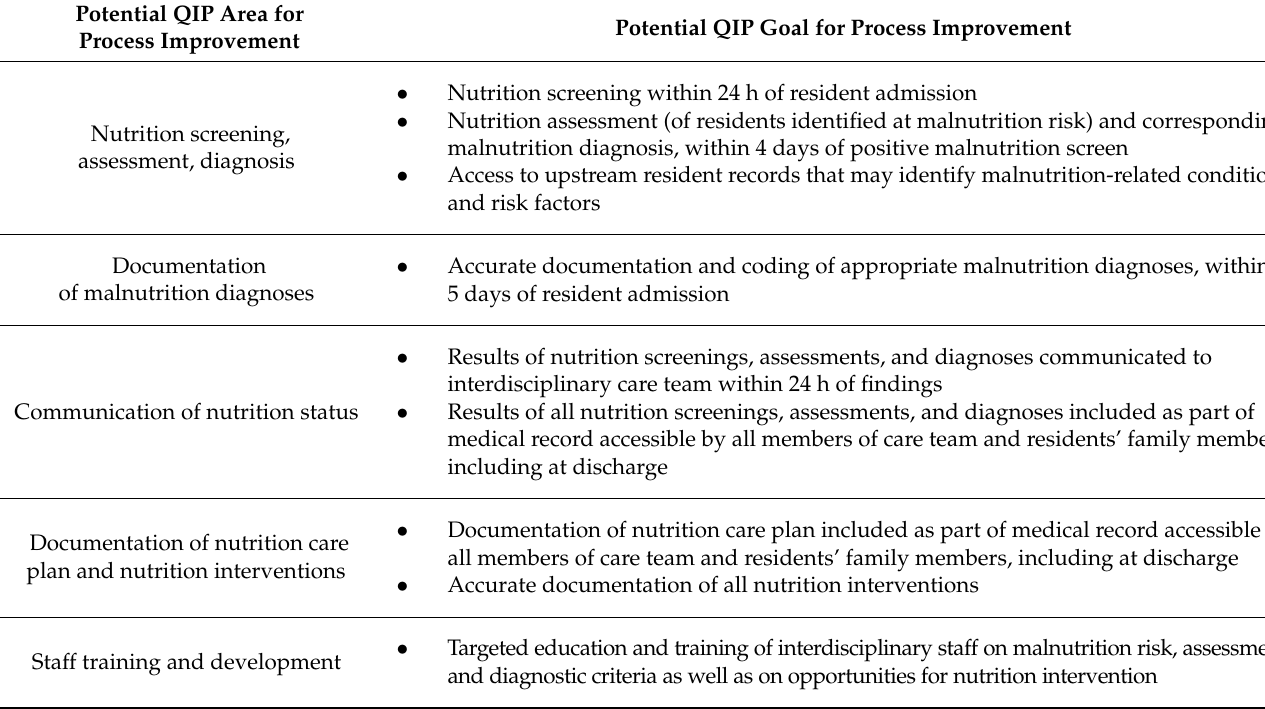
Table 4. Potential areas and goals for nutrition-focused quality improvement programs (QIPs) to target malnutrition care process improvement in skilled nursing facilities